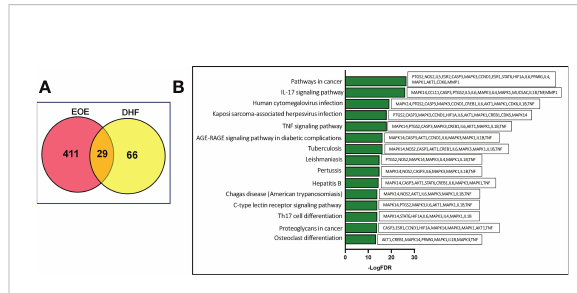
FIGURE 2 Computational identi fi cation and KEGG pathway analysis of the therapeutic targets. (A) Venn diagram showing the number of targets predicted using computational modeling. Among them 29 targets were shared between DHF and EoE. (B) KEGG Pathway analysis. Y-axis: The top 15 pathway relevant to the enriched targets (left) and genes associated with each pathway (right); X-axis: the signi fi cance of each term ranked with – log FDR. DHF, 7,4-dihydroxy fl avone, EoE, Eosinophilic Esophagitis, FDR, False discovery rate.